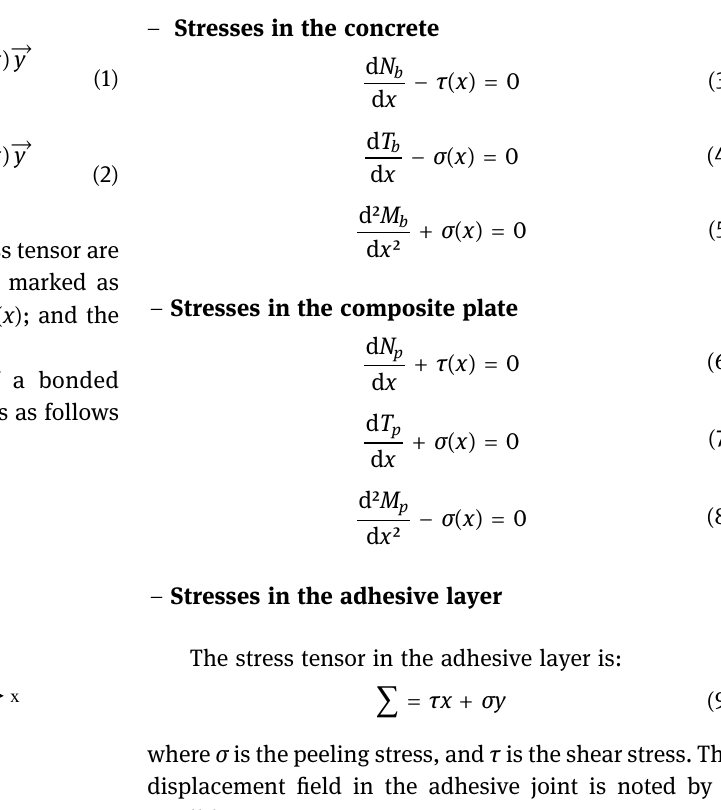
Figure 2: Analytical model.